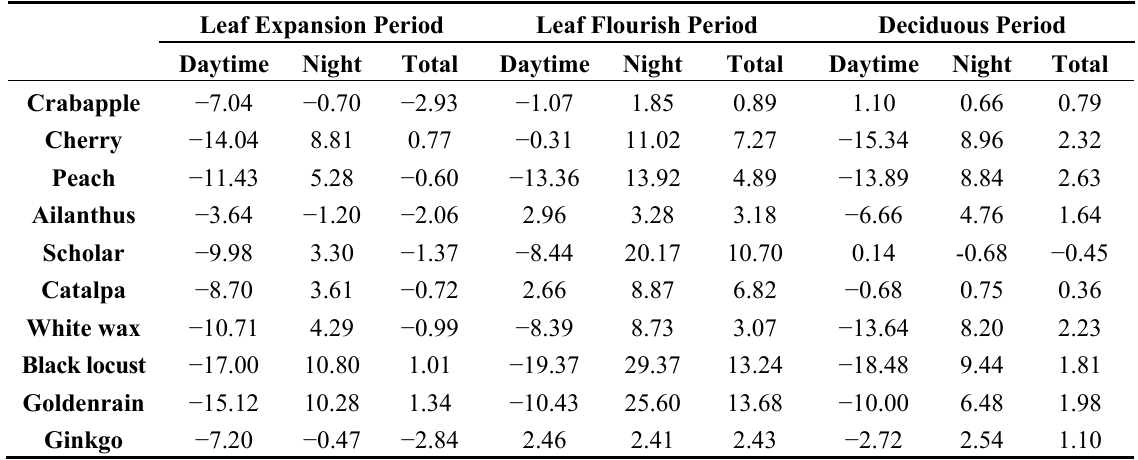
Table 2. Particulate matter (PM) 2.5 concentration index in different